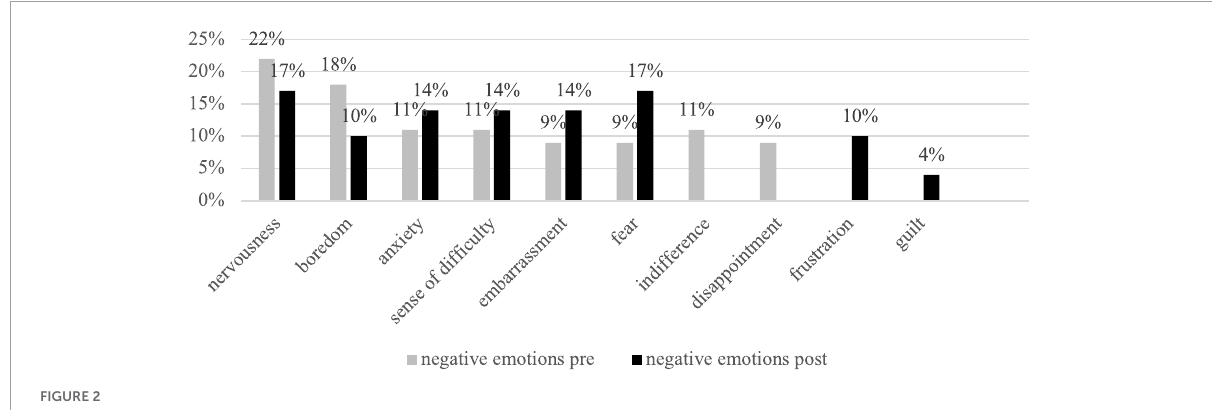
FIGURE2 Overall negative emotions from pre- and post-written narratives by the 32